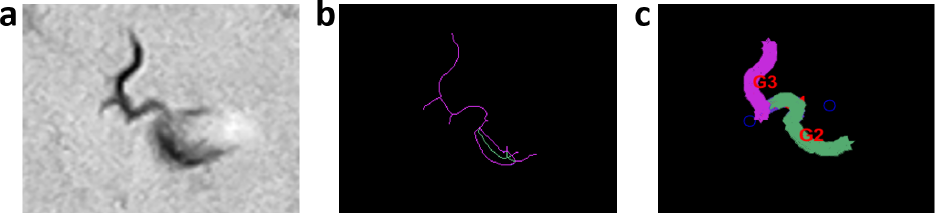
Figure A11. Model 7 evaluation, example 5. Errors occurred by the presence of noise. ( a ) Grayscale image. ( b ) Resulting skeleton using the improved form of skeletonizing ( c ) Optimization